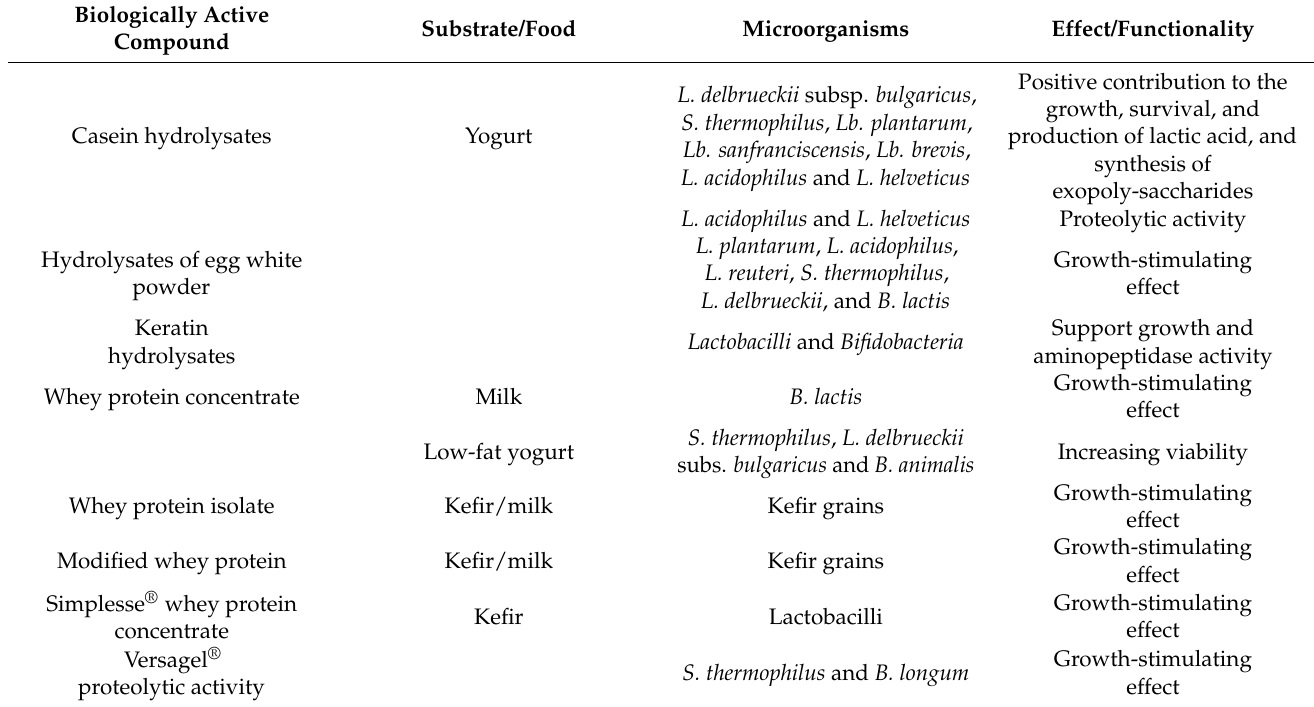
Table 2. The most notable amino acid bioactive